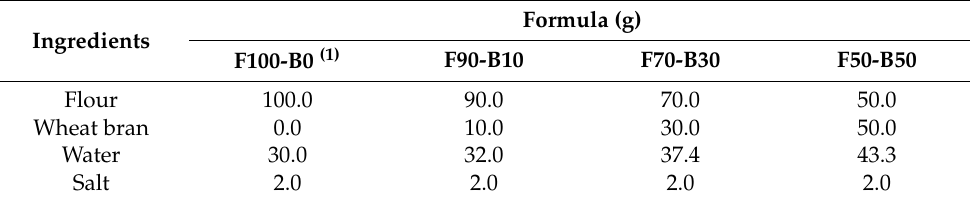
Table 1. Ingredients and formula used for preparing fresh noodles made with flour-bran blends at different